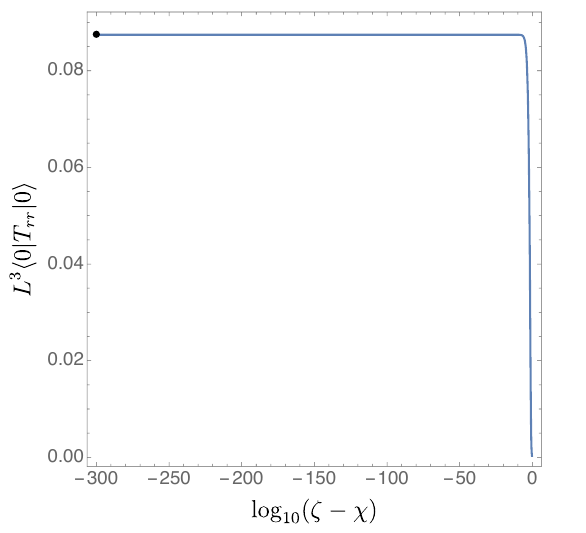
Figure 5 . Plot of L 3 h 0 j T rr j 0 i as a function of log (cid:12) = 3 = 2. The black dot denotes L 3 t rr